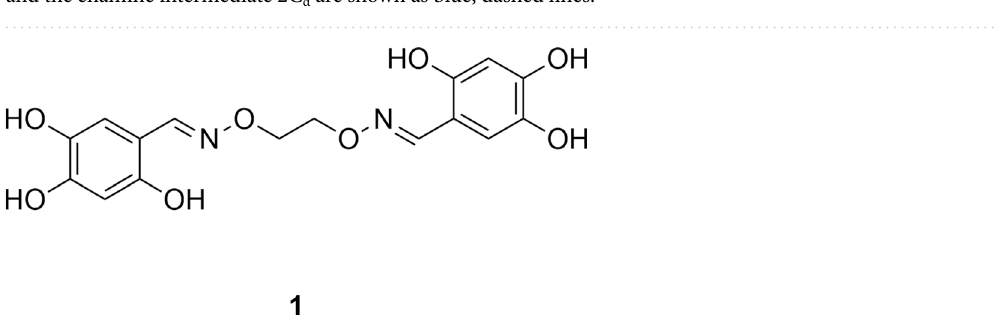
Figure 5. ∆ Mt DXPS D-GAP binding site with modeled phosphate and docked D-GAP. ( a ) ∆ Mt DXPS structure (PDB ID: 7A9G ) with polder map density contoured at 3σ in gray wire mesh for the phosphate. Key residues involved in the interaction with the phosphate are shown in stick representation and labeled. Hydrogen bonds are shown as black, dashed lines. ( b ) D-GAP molecule docked into the D-GAP binding site of ∆ Mt DXPS after removal of the phosphate. The polder density map of the phosphate present in the crystal structure is shown to highlight the similar orientation and interactions of the 3-phosphate moiety of D-GAP to the modeled phosphate. The residues predicted to interact with the docked D-GAP are shown in stick representation and are labeled. Predicted hydrogen bonds are shown as black, dashed lines, while the distance between the D-GAP C3 and the enamine intermediate 2C α are shown as blue, dashed lines.